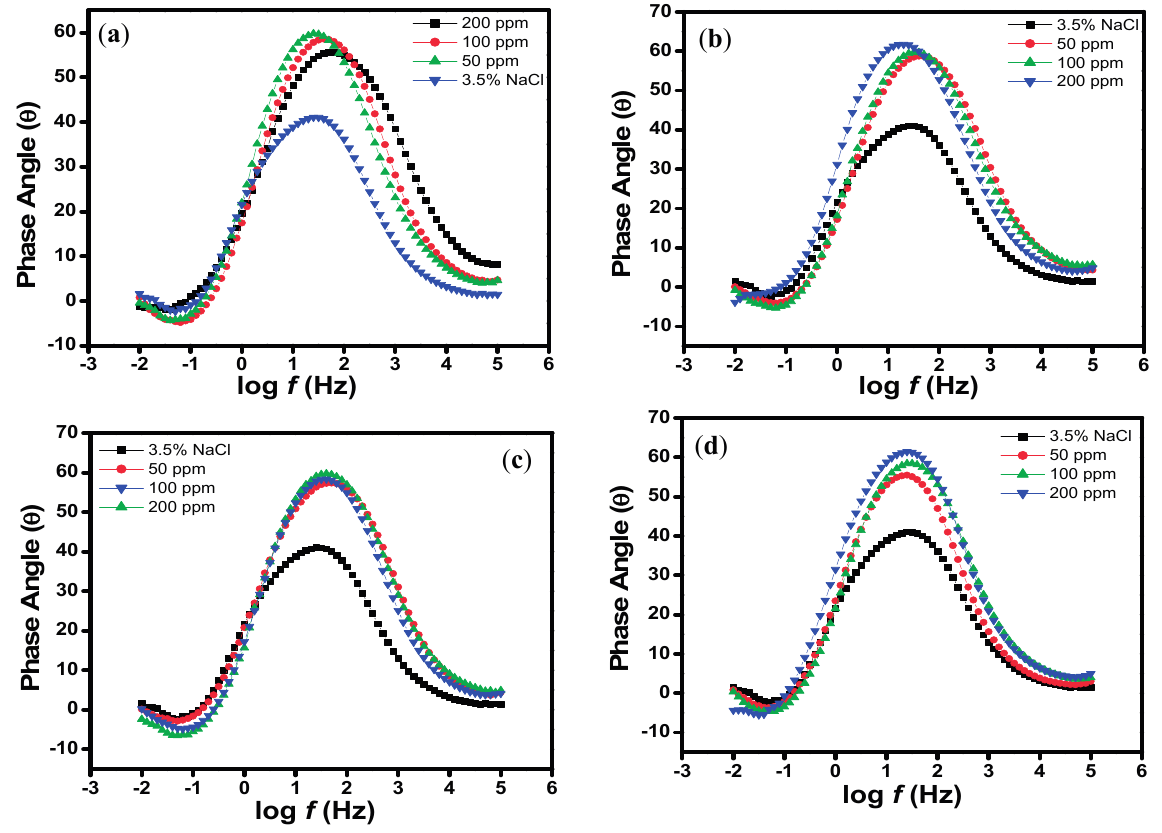
Figure 4. Bode phase angle plots of N80 steel in 3.5% NaCl saturated with CO 2 without and with various concentrations of ( a ) HPTB; ( b ) T4PP; ( c ) THP and ( d )